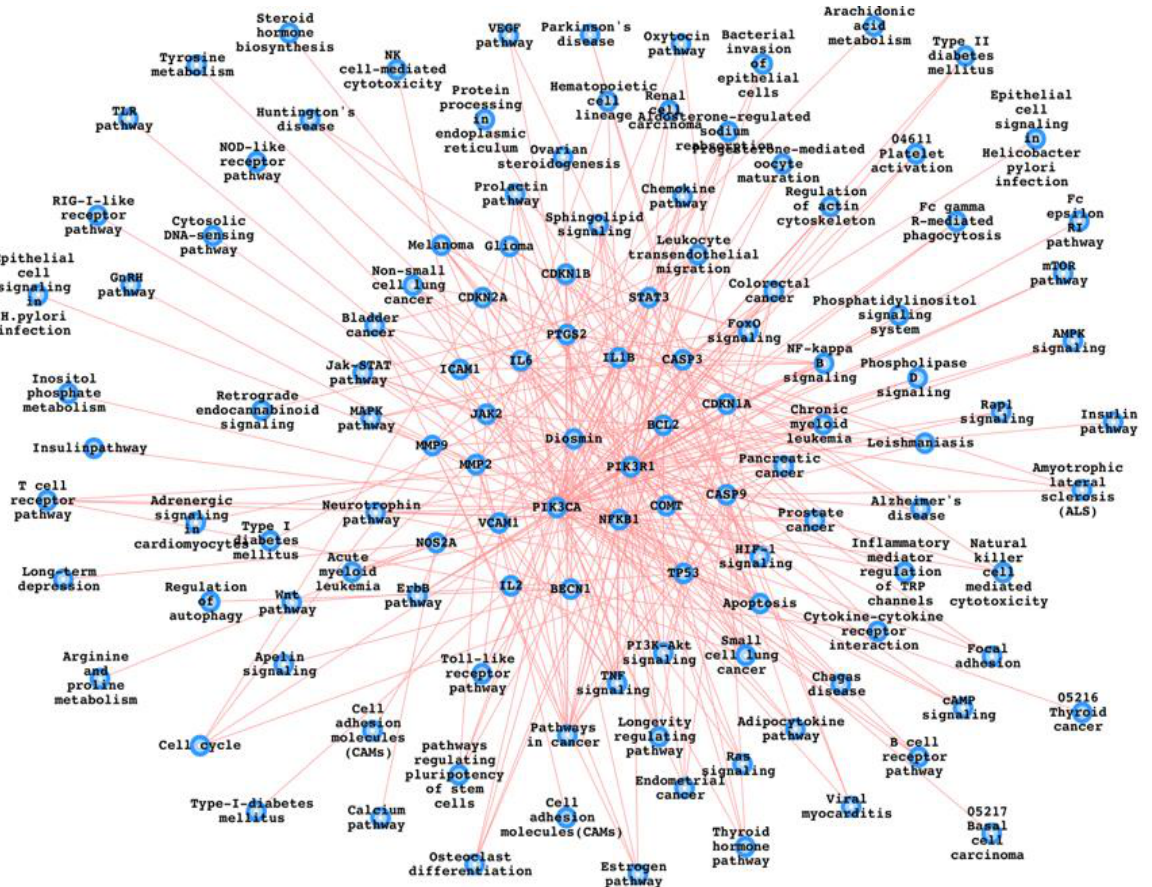
Figure 3. Diosmin-associated proteins and the biological pathways. We have used FunCoup database for PPI (protein–protein interactions) and integrated it with the KEGG pathways list, and the same has been mentioned in the main text also and the same has been done for Table 1 [72–79]. To prepare this pathways list, we have first used SwissTargetPrediction (http://www. swisstargetprediction.ch/predict.php) (accessed on 21 December 2021) to generate the proteins which could bind with Diosmin and then mapped out the KEGG pathways from the KEGG database (https://www.genome.jp/kegg/pathway.html) (accessed on 21 December 2021) for these Diosmin interactors (proteins). Table 1 contains the overall pathways and the respective proteins while similar information is presented in Figure 3 as a network of Diosmin, its interactors, and the